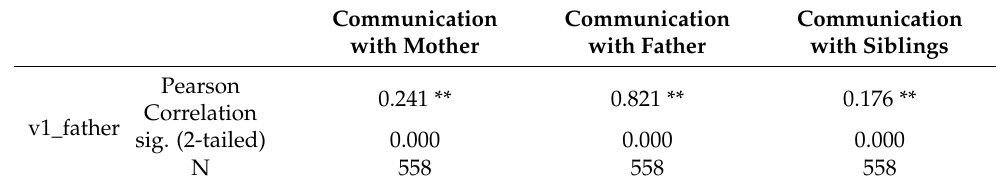
Table 2. Correlation of father–adolescent relationship with family communication.